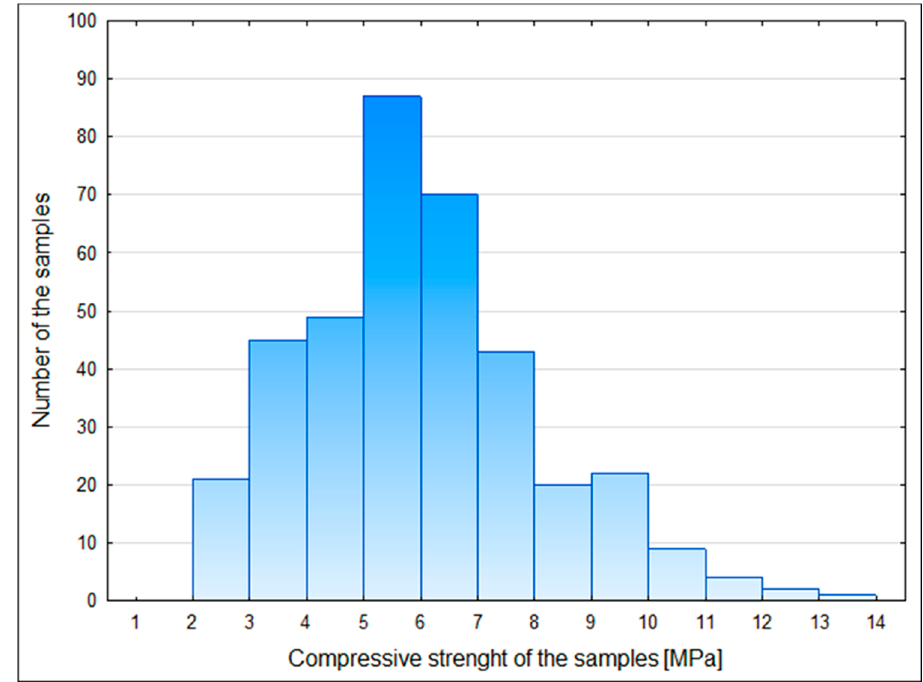
Figure 7. Histogram of the compressive strength of the samples.